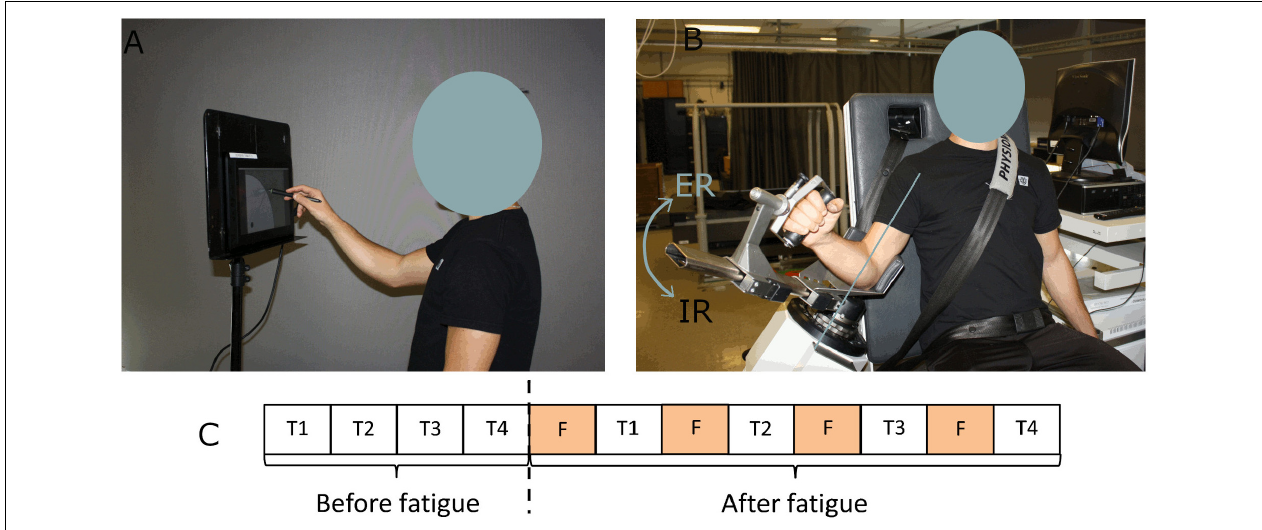
FIGURE 1 | Experimental set-up. (A) Position of the participant while drawing strokes. (B) Setup of the participant on the dynamometer for the fatigue protocol. (C) Chronology of a session. T corresponds to a series of fast strokes (simple strokes, triangles, horizontal, and vertical oscillations) and F to a task of